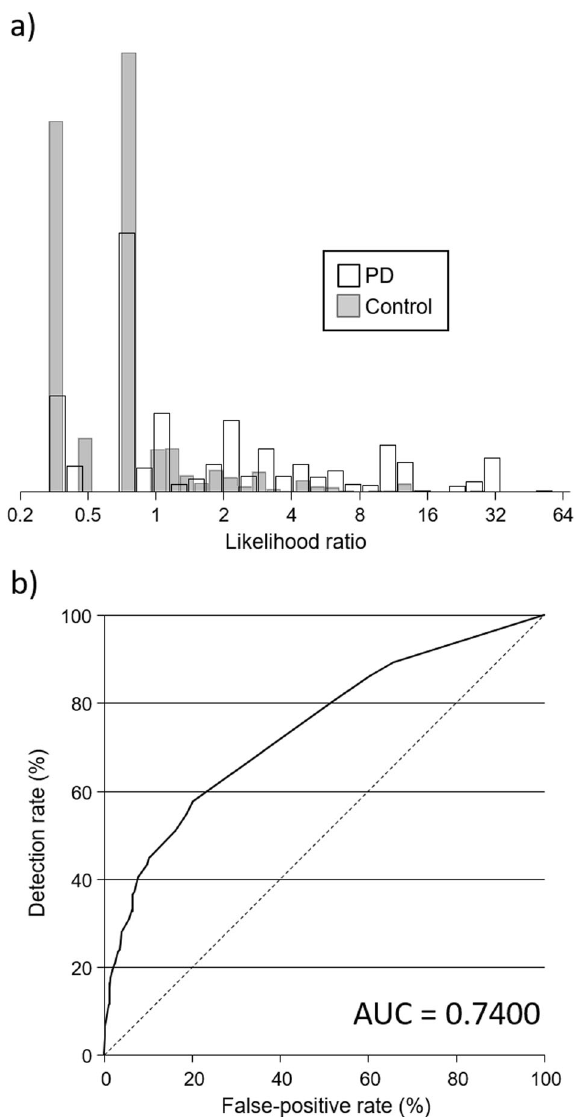
Fig. 2 Classi fi cation of Parkinson ’ s Disease (PD) based on the REM-sleep behaviour Screening Questionnaire (RBDSQ). a Dis- tribution of likelihood ratios among PD cases and controls using the 6 questions of the RBDSQ identi fi ed as being associated with PD (see Table 2). b The observed detection rate according to false- positive rate (receiver operating characteristic curve) for the 6 questions of the RBDSQ identi fi ed as being associated with PD. AUC, area under the receiver operating characteristic After transforming values into delta values for KS and MoM values for AT using the above regression equations, mean KS values were 12.8 points lower in PD cases than in controls, and AT values 36% higher (both p < 0.001). Supplementary Fig. 3 shows probability plots for delta KS values (3a) and AT MoM values (3b), with AT MoM values plotted on a log scale. Delta KS values start to deviate, or the data were sparse, below − 30 and above 10, and for AT below 0.5 MoM and above 3.0 MoM. These values were therefore used as truncation limits. However, the point of risk reversal for AT was at 0.75, so values less than this were truncated. All distributions were reasonably Gaussian as indicated by the points roughly falling on straight lines. Figure 4 shows the distribution of delta KS (4a) and AT MoM (4b) values in PD cases and controls. KS had the best discrimination between PD cases